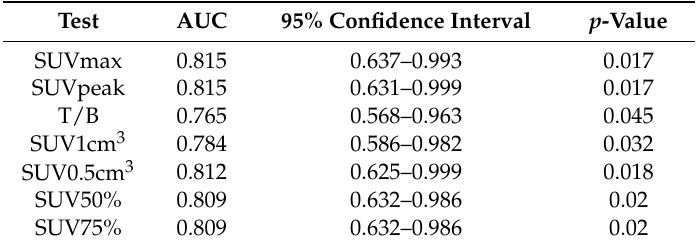
Table 4. ROC curve analysis for each parameter. The higher the area under the curve (AUC) the better the discriminatory power between positive and negative lesions. SUVmax has the best performance (as depicted by the AUC values and confidence intervals). p < 0.05 is considered statistically significant.